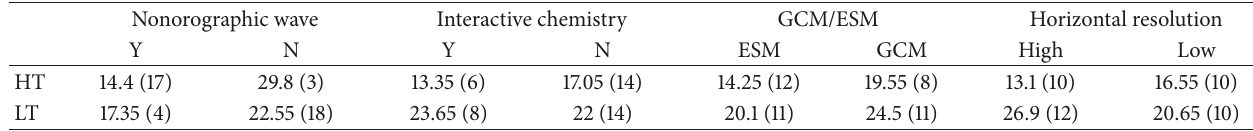
Table 4: The median value of the model rankings of the mean temperatures in the stratospheric polar vortex region, classified into 4 pairs of groups for the high-top models and low-top models. The numbers in brackets are the number of models in each model